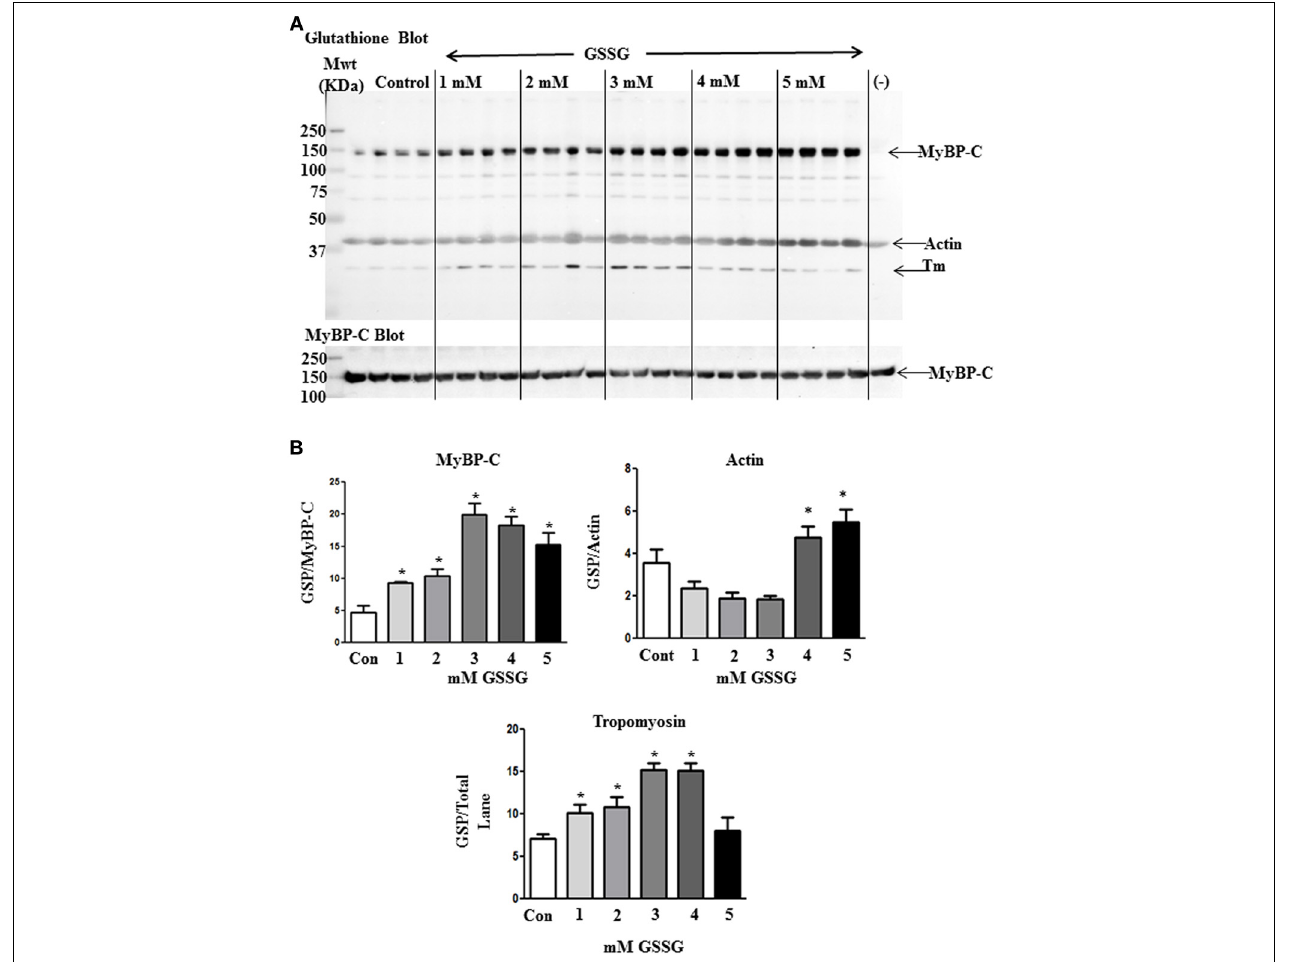
FIGURE 2 | Western blot analysis of proteins subject to glutathionylation during ATPase assay. (A) Control myofibrils and myofibrils treated with increasing concentrations of GSSG (20 µ g) were probed with anti-GSH (Virogen) antibody to detect glutathionylated proteins. ( − ) lane contains myofibrils treated with 10mM DTT after 5mM GSSG treatment to serve as a negative control. The blot was also probed